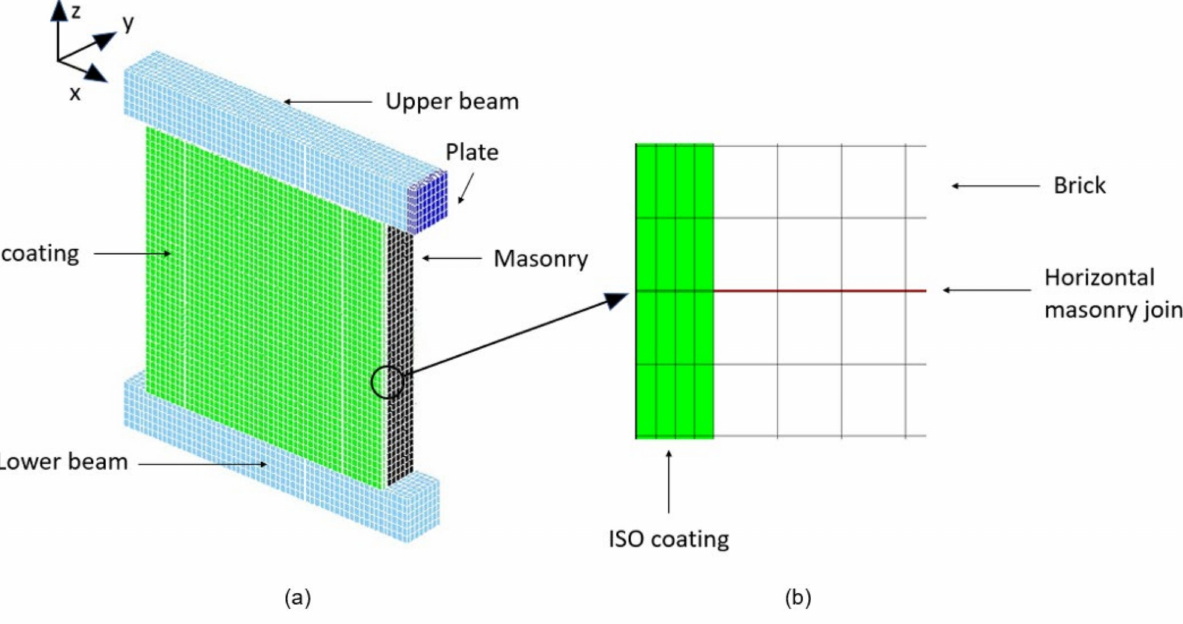
Figure 8. Numerical configuration of the MGF wall ( a ) and side view of the coating model ( b